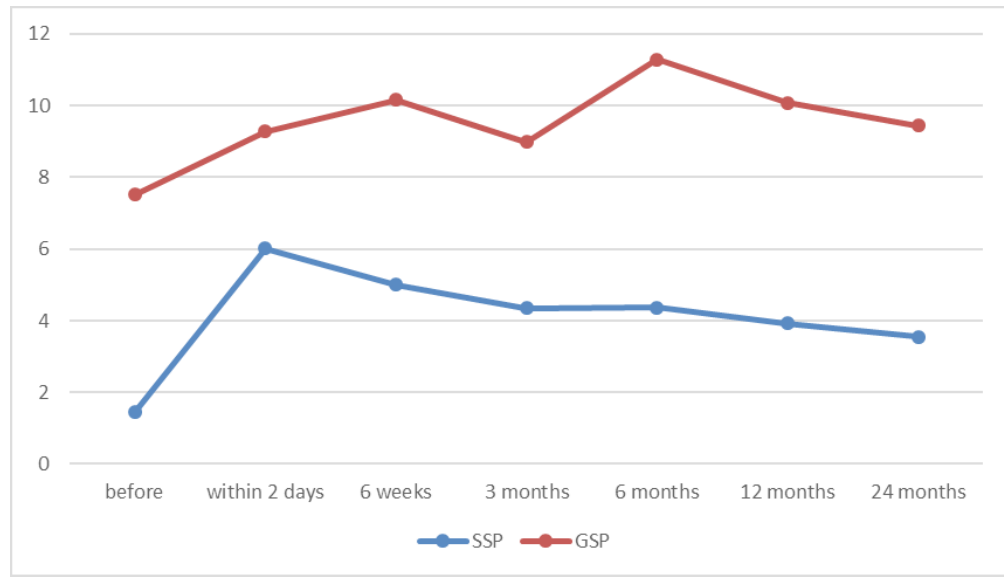
Fig. 3. The trend graph of SSP and GSP development after the ACDF (represented in